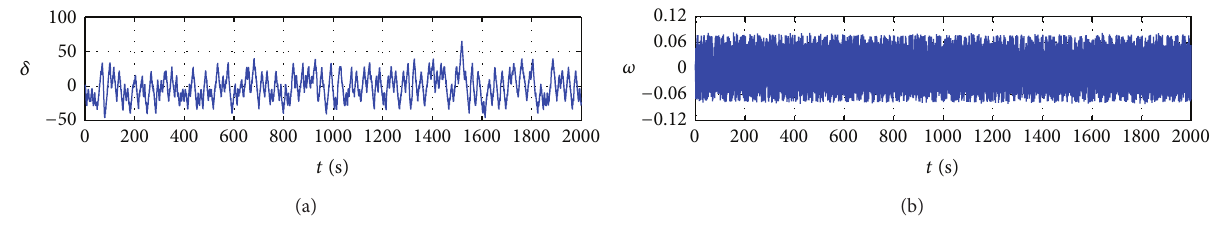
Figure 16: Time waveforms of 𝛿 and 𝜔 with 𝐾 𝑖 = 1 , 𝐾 𝑝 = 2 , and 𝐾 𝑑 = 6.5 .